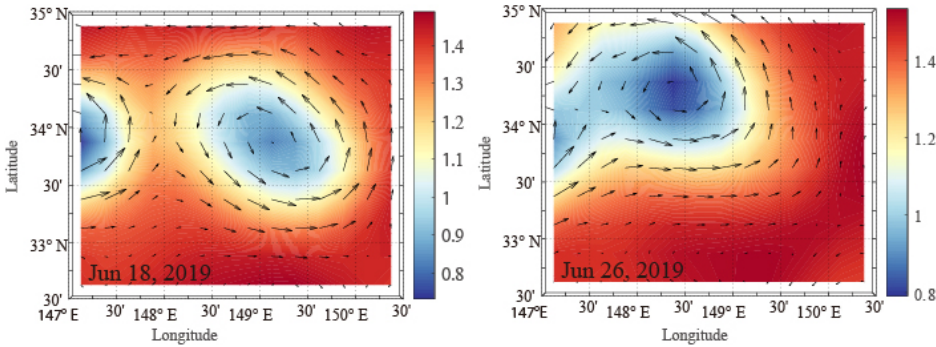
Figure 3. ARMOR 3D sea surface heights and geostrophic velocities on 18 June to 26 June 2019.